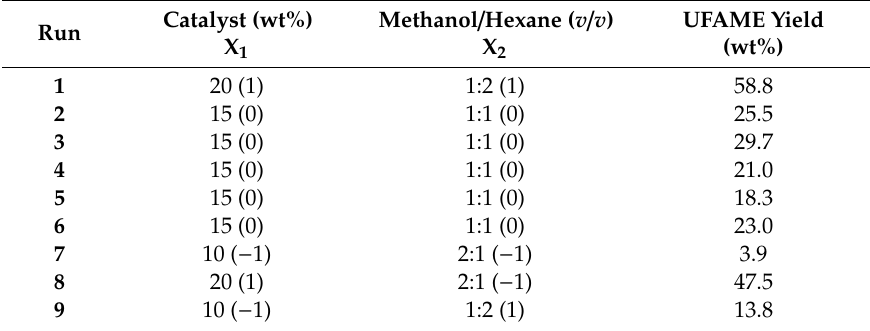
Table 1. Experimental design of the e ff ects of independent variables on UFAME